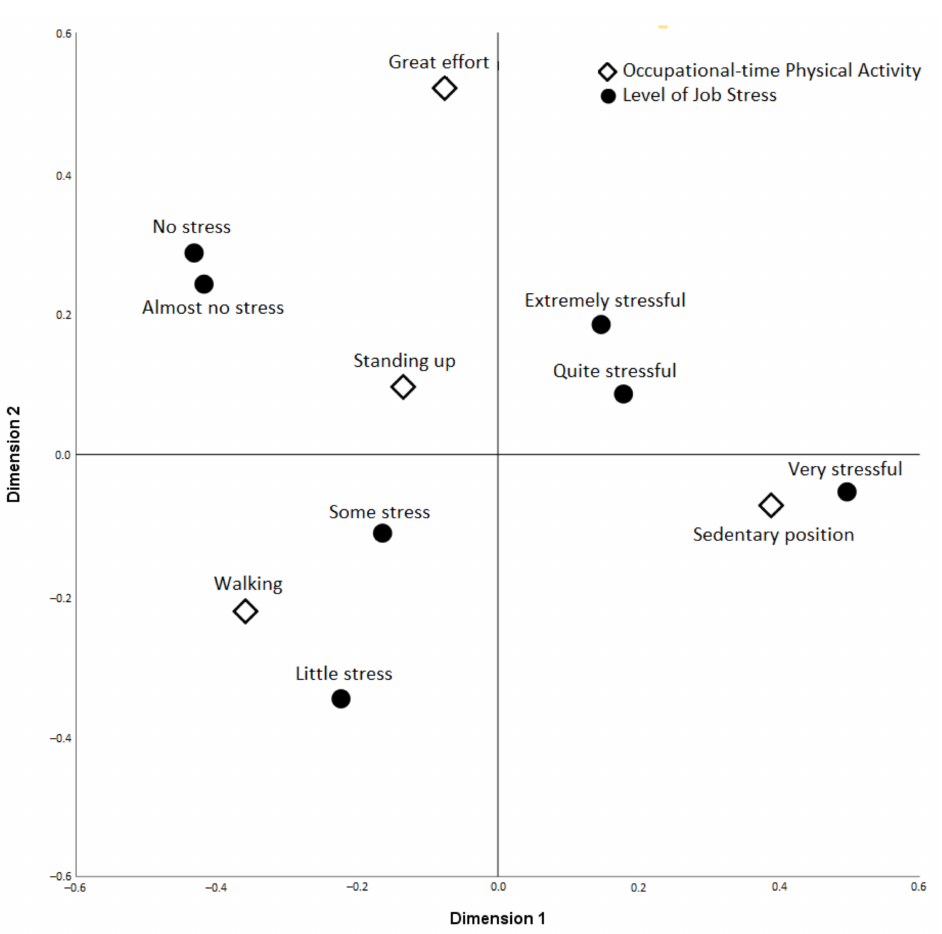
Figure 2. Simple correspondence analysis between job stress level and occupational physical activity